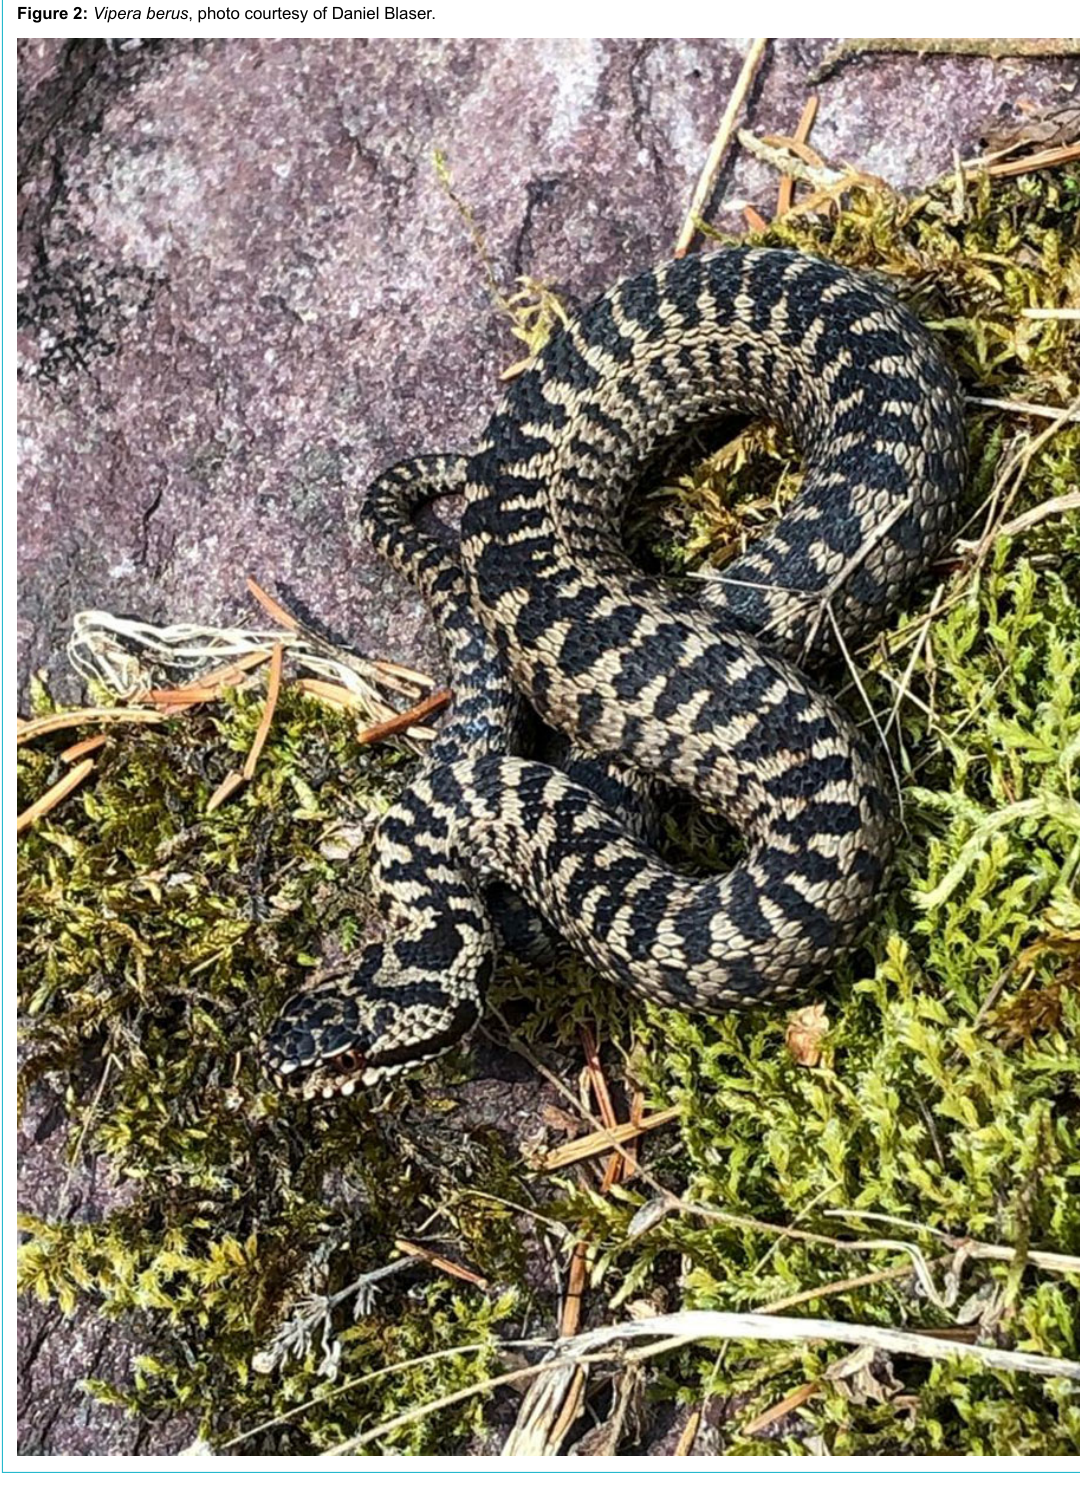
Figure 2: Vipera berus , photo courtesy of Daniel